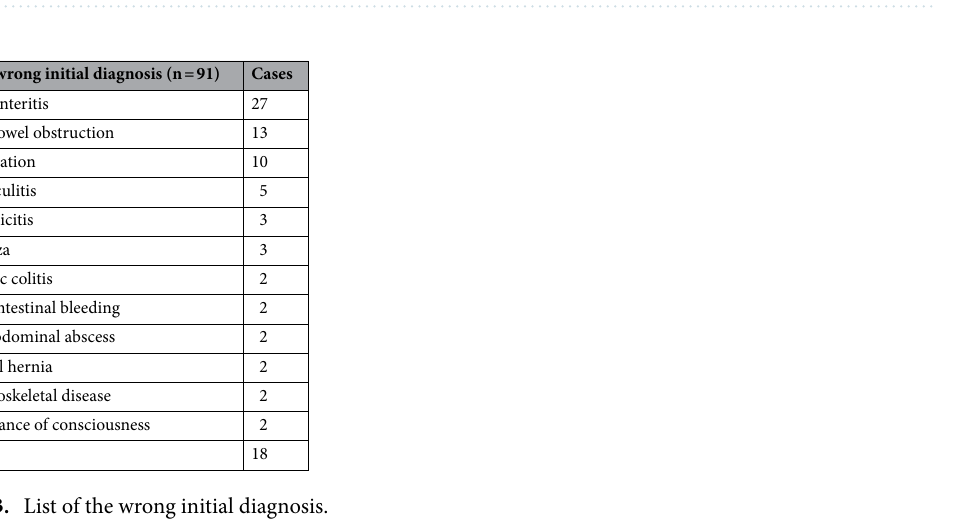
Table 2. Results of the multivariate logistic regression analysis on associated factors of lower gastrointestinal perforation.